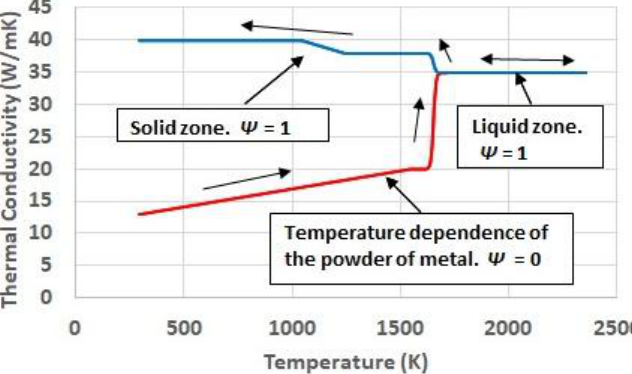
Figure 5. Temperature and phase dependence of thermal conductivity.